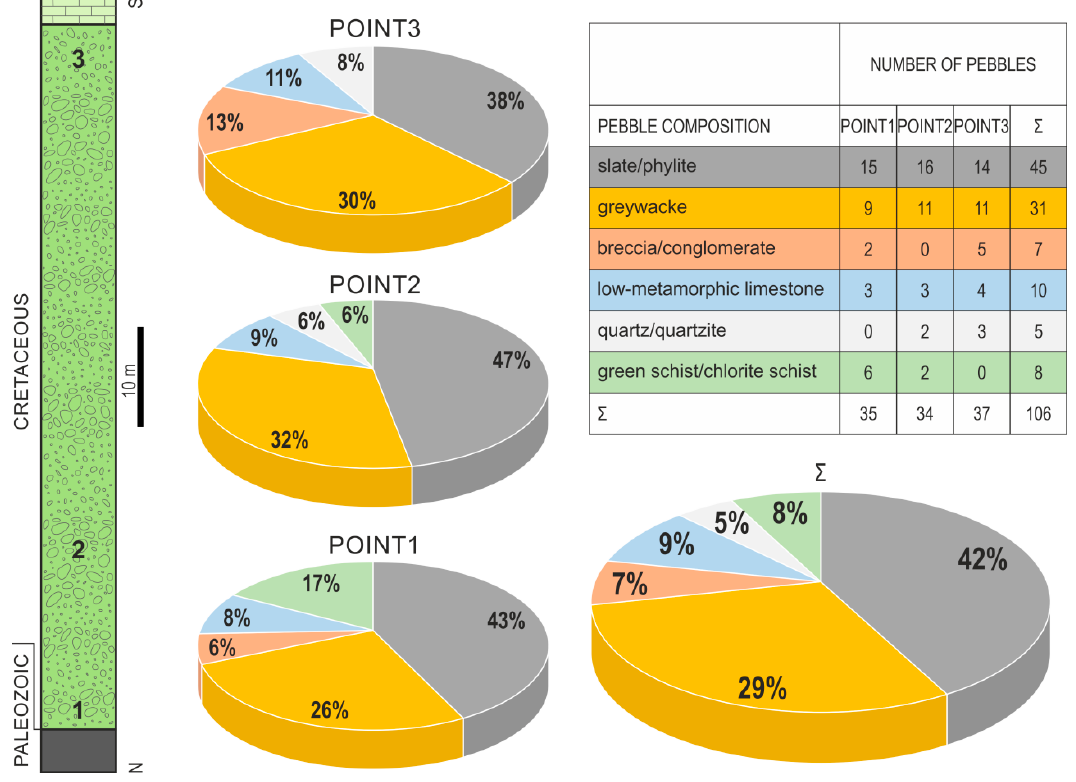
Figure 4. Modal composition of conglomerates based on 106 pebbles collected at Statistic Stops 1–3. Position of Statistics Points marked on a schematic column.